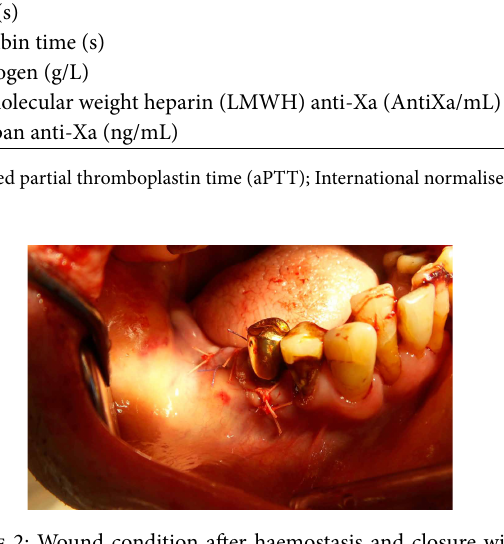
Figure 2: Wound condition after haemostasis and closure with a vestibular mucoperiosteal